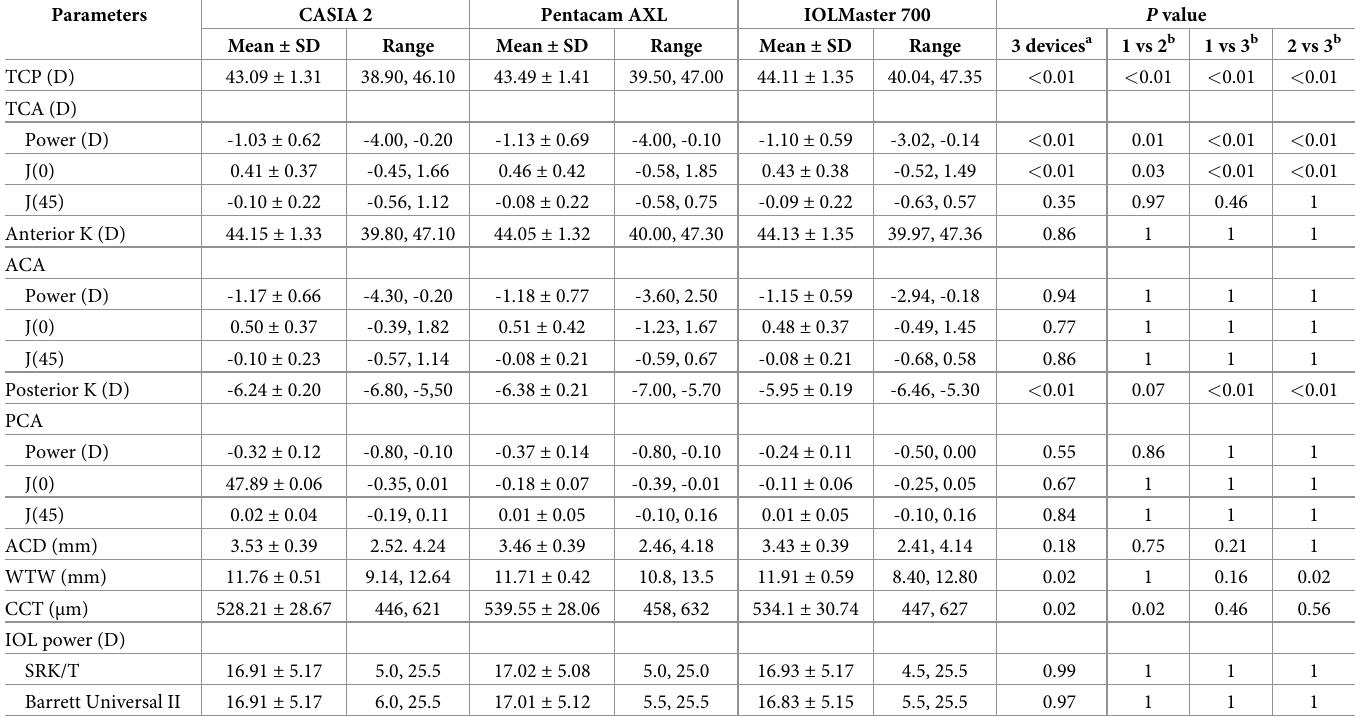
Table 2. Biometric measurements with CASIA 2, Pentacam AXL, and IOLMaster 700 in normal participants.